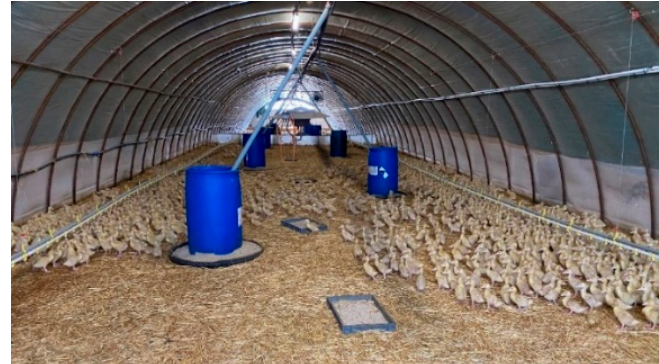
Figure 3. A typical view inside the barn (experimental location).